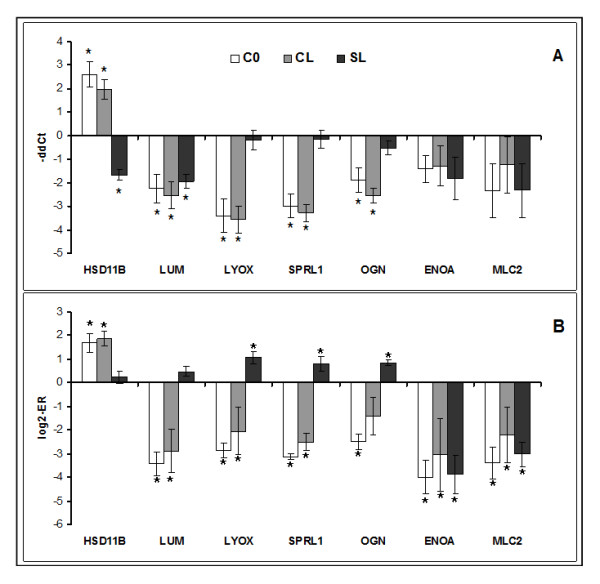
Results of qPCR (A) and microarray (B): expression changes of genes implicated in steroid metabolism (11-beta-hydroxysteroid dehydrogenase, HSD11B), formation of extracellular matrix (lumican, LUM; protein-lysine 6-oxidase, LYOX, SPARC precursor, SPRL1) and bone (mimecan or osteoglycin, OGN), contraction (enolase 3, ENOA, myosin regulatory light chain 2, MLC2). Cortisol injected fish (C0), cortisol injected and lice challenged fish (CL) and sham injected and lice challenged fish (SL) were compared to the sham injected group (S0). Data for qPCR are -ΔΔCt ± SE of 8 fish per group, 4 of which were used for the microarray analysis. Asterisks denote significant difference from S0 (P < 0.05). Data for microarrays are mean log2-ER ± SE of 4 fish hybridized to a common reference sample; sham injected control (S0) was subtracted from each group.